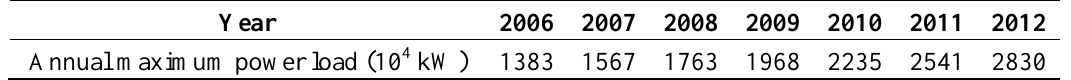
Table 2. Power load forecasting result of the MSPLF